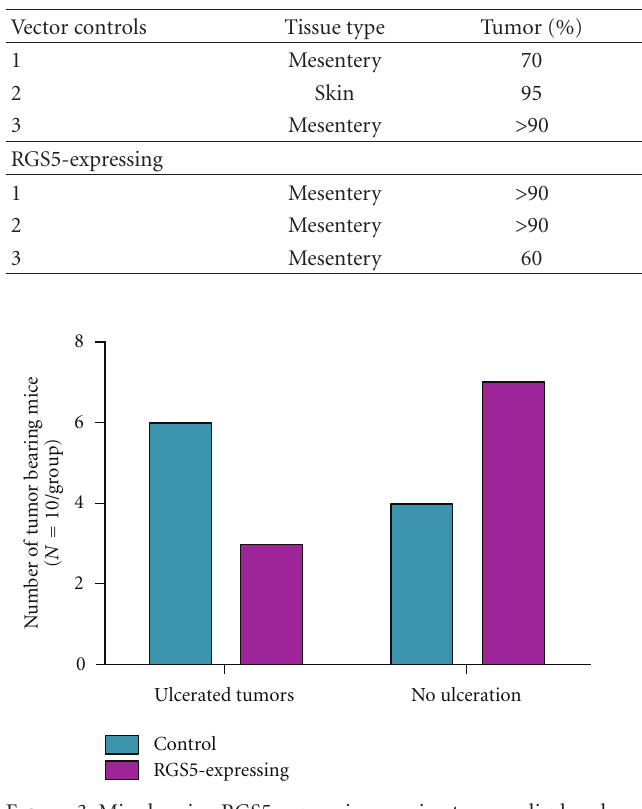
Figure 3: Mice bearing RGS5-expressing ovarian tumors displayed less frequent tumor ulceration . The number of mice with ulcerated tumors observed at necropsy was recorded ( N = 10 per group). Tumor sizes were relatively similar between the two